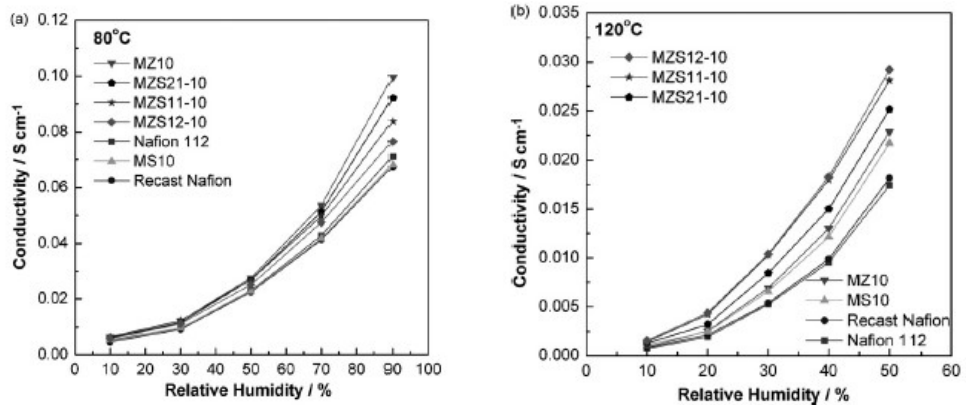
Figure 9. The measured conductivity of the membranes over different RH levels, where the membranes are labeled MZSxy-10 and x:y is Zr:Si, at 80 °C ( a ) and at 120 °C ( b ). Reprinted with permission from Ref. [49]. Copyright 2008 Elsevier.